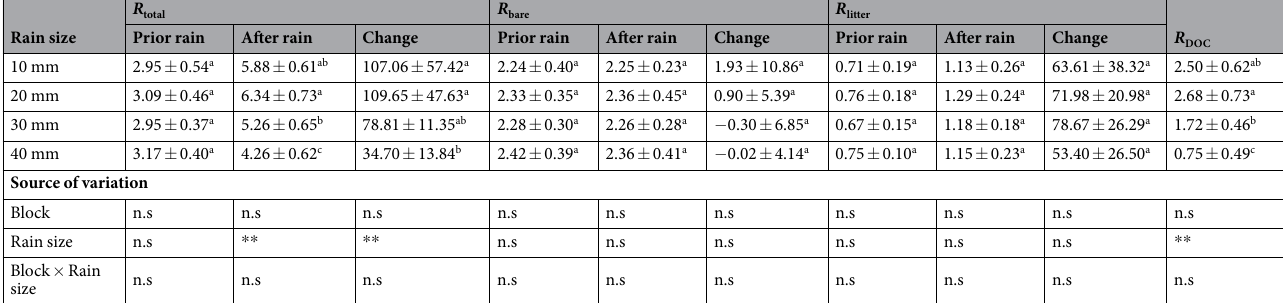
site 38 . Future experiments with stable isotope technique and trenching method are needed to further test these underlying mechanisms. Previous studies suggested that the intensity/size of rainfall has positive influence on soil CO 2 pulses 17, 39 . In this study, we found that rain-induced increase in R total was significantly lower at the large than small rain size (Table 1). This might not be attributable to excessive water content and decreased soil O 2 diffusion, as the simu- lated rains had no significantly effect on R bare for all the rain sizes (Table 1). In addition, the rain-induced R litter did